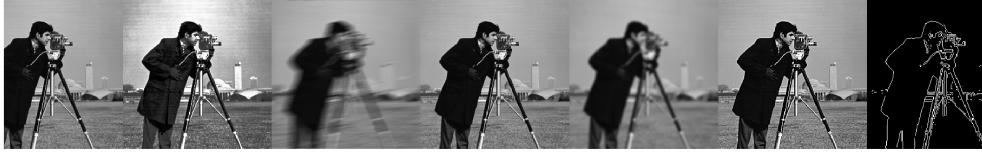
Figure 2. Output for different image enhancement methods. The operations applied, from left to right, are: original image, histogram equalization, motion blur, deblur using Wiener filter, smoothing with Gaussian filter, image sharpening, edge detection with Sobel